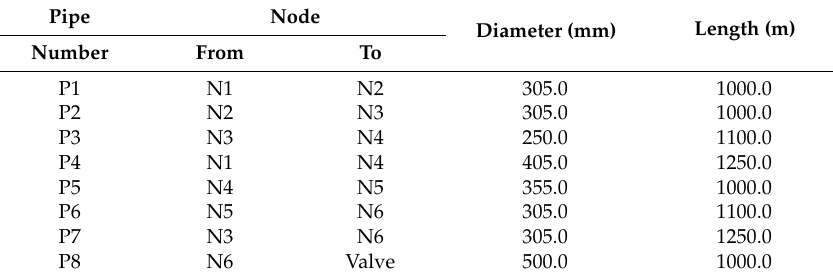
Table 1. The characteristics of the synthetic pipe network A.